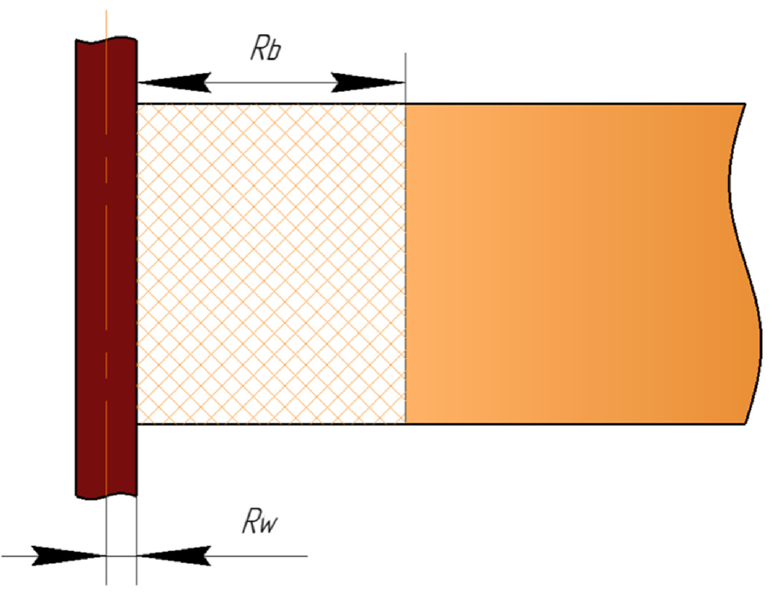
Figure 10. Water shutoff barrier located in the near-wellbore zone. R b —radius of forming barrier, m; Rw— the wellbore radius, m.